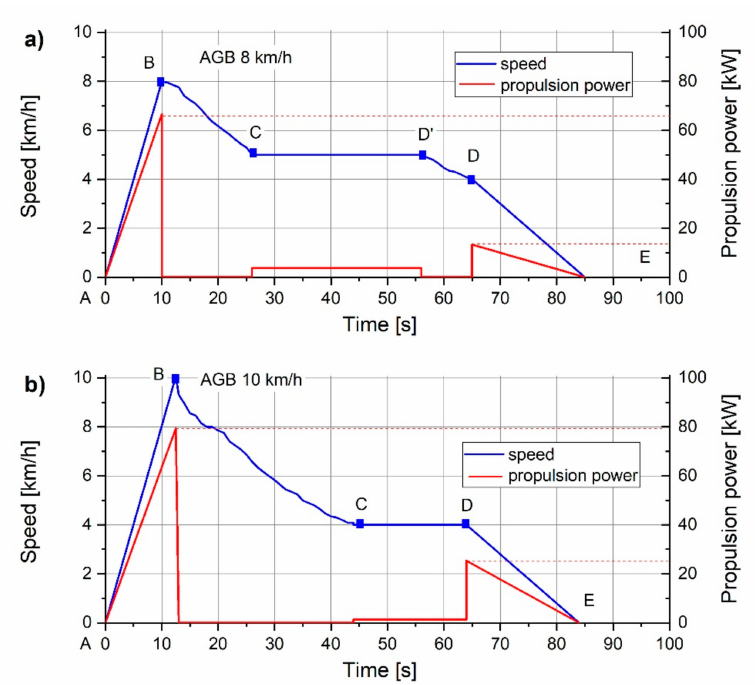
Figure 8. Ship speed and power demand for the AGB strategy: ( a ) Maximum speed of the acceleration stage of 8 km / h, ( b ) maximum speed of the acceleration stage of 10 km / h; A—start, B—end of